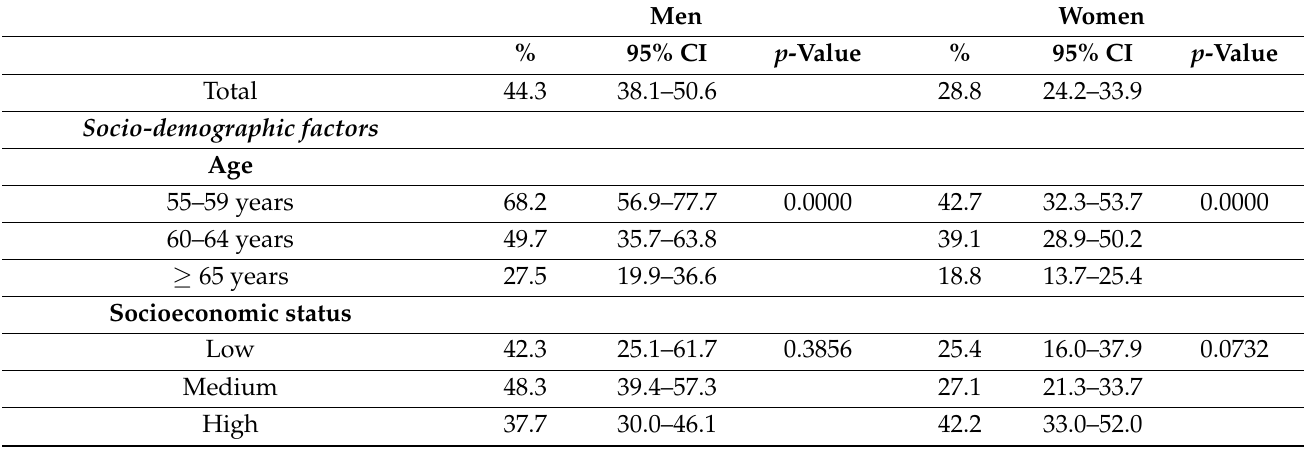
Table 2. Intention to participate in screening colonoscopy by the examined determinants (relative frequencies expressed as